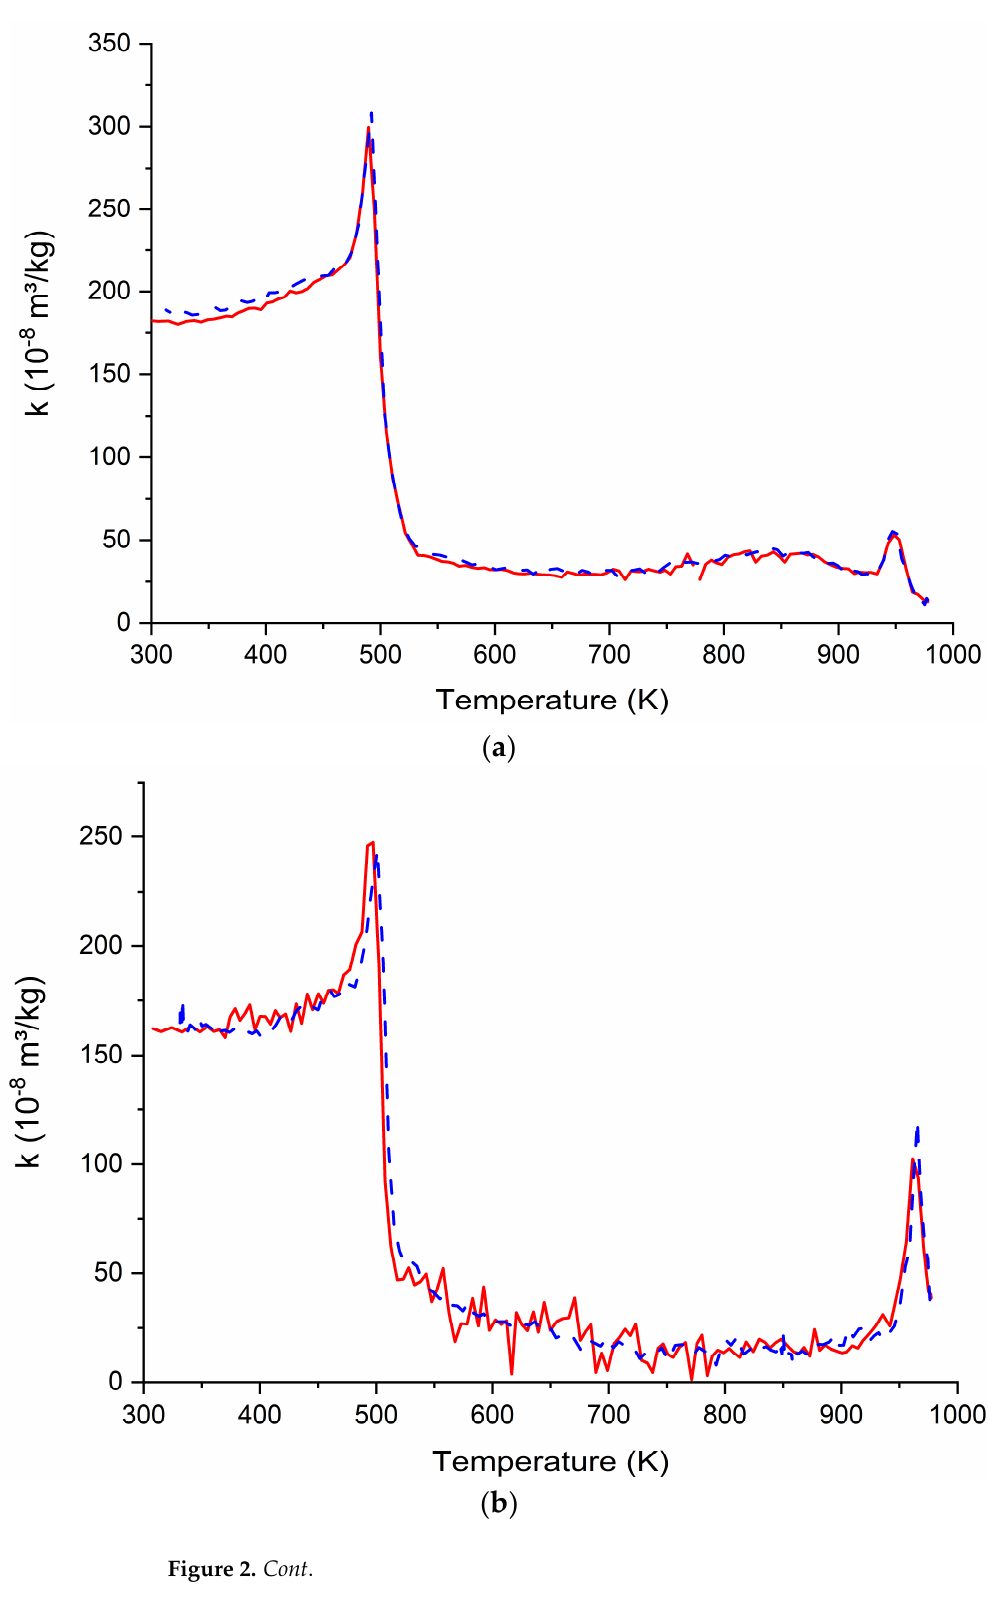
Figure 3 illustrates the low-temperature remanence behavior and hysteresis loops measured at 295 K for two samples that show coercivities in excess of 1 Tesla, as expected for the ε -Fe 2 O 3 phase [24,44,46–50].